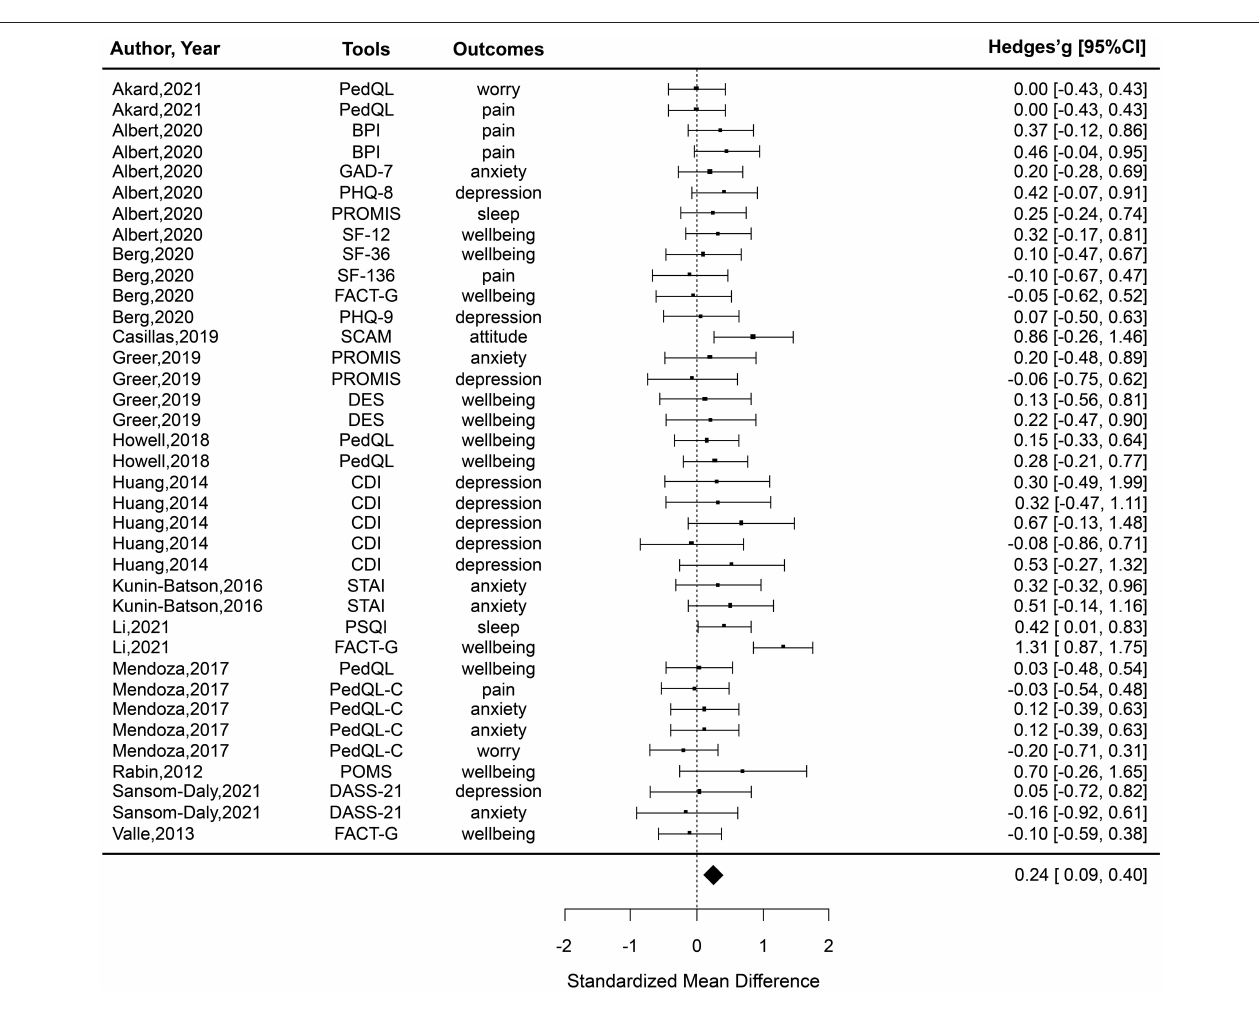
FIGURE 3 | All effect sizes included in the meta-analysis from the studies comparing online interventions to a control